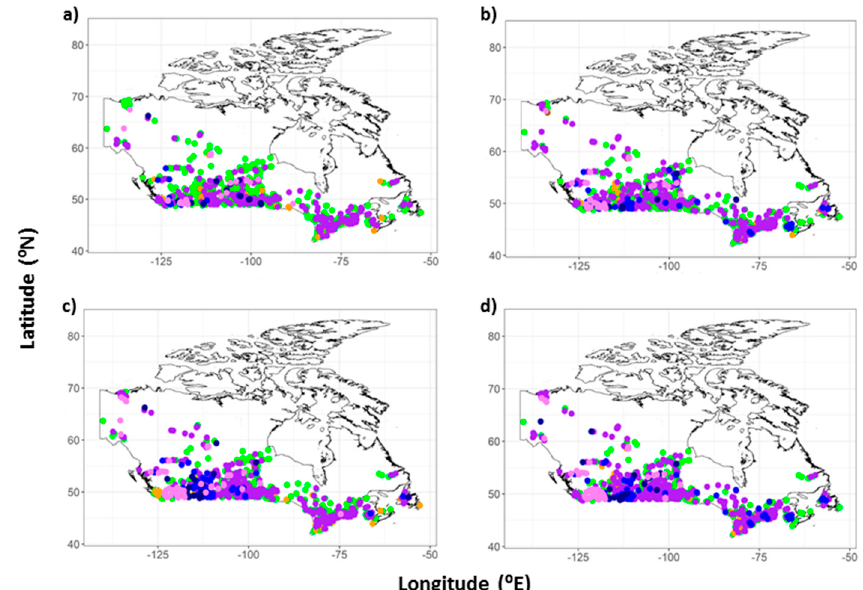
Figure 6. The change in flood timing obtained from all GCM median approach at FRIs under ( a ) RCP 2.6, ( b ) RCP 4.5, ( c ) RCP 6.0, and ( d ) RCP 8.5. FRIs projected with no change in flood timing are shown in green. FRIs projected with earlier occurrences of floods are shown in shades of blue (purple for 1 month shift, blue for 2 months shift, and dark blue for 3 month shift). FRIs projected with later occurrences of floods are shown in shades of orange (1–3 month shifts shown in light to dark orange). Finally, FRIs where 4 or more months of changes (in either direction) are projected, are shown in pink.